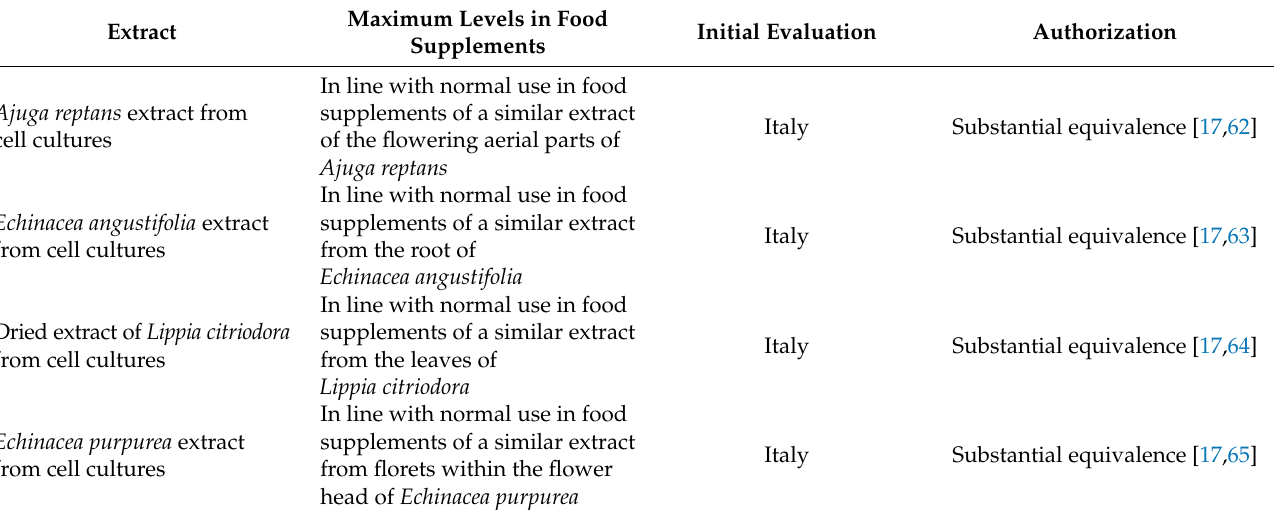
Table 3. Cell culture extracts authorized as novel foods for their use in food